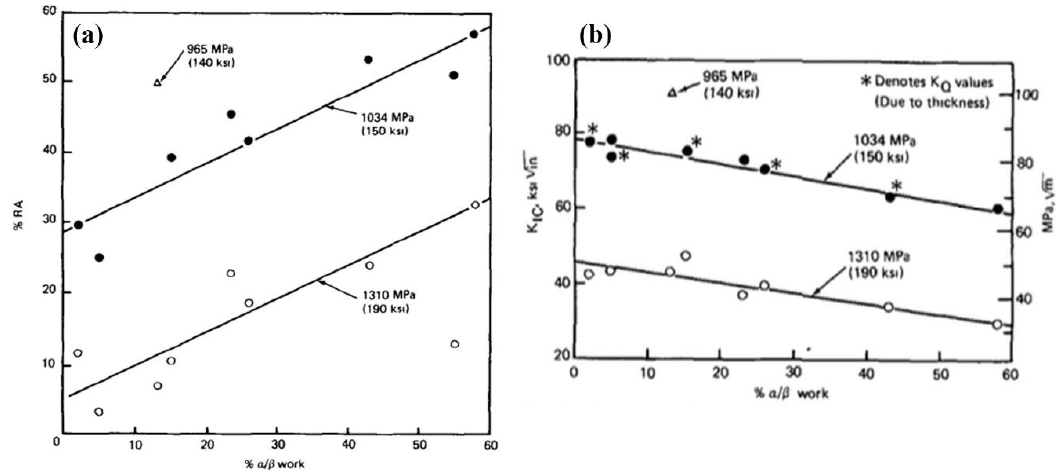
Figure 9. For the near-beta Ti-10V-2Fe-3Al (wt. %) alloy, the relationship between the amount of work in the α + β phase field and ductility is illustrated in ( a ) and fracture toughness is shown in ( b ) [106]. (Reprinted by permission from Metallurgical Transaction A, vol. 18, no. 12, R. R. Boyer and G. W. Kuhlman, Processing properties relationships of Ti-10V-2Fe-3Al, 2095–2103, 1987, with permission from Springer Nature).